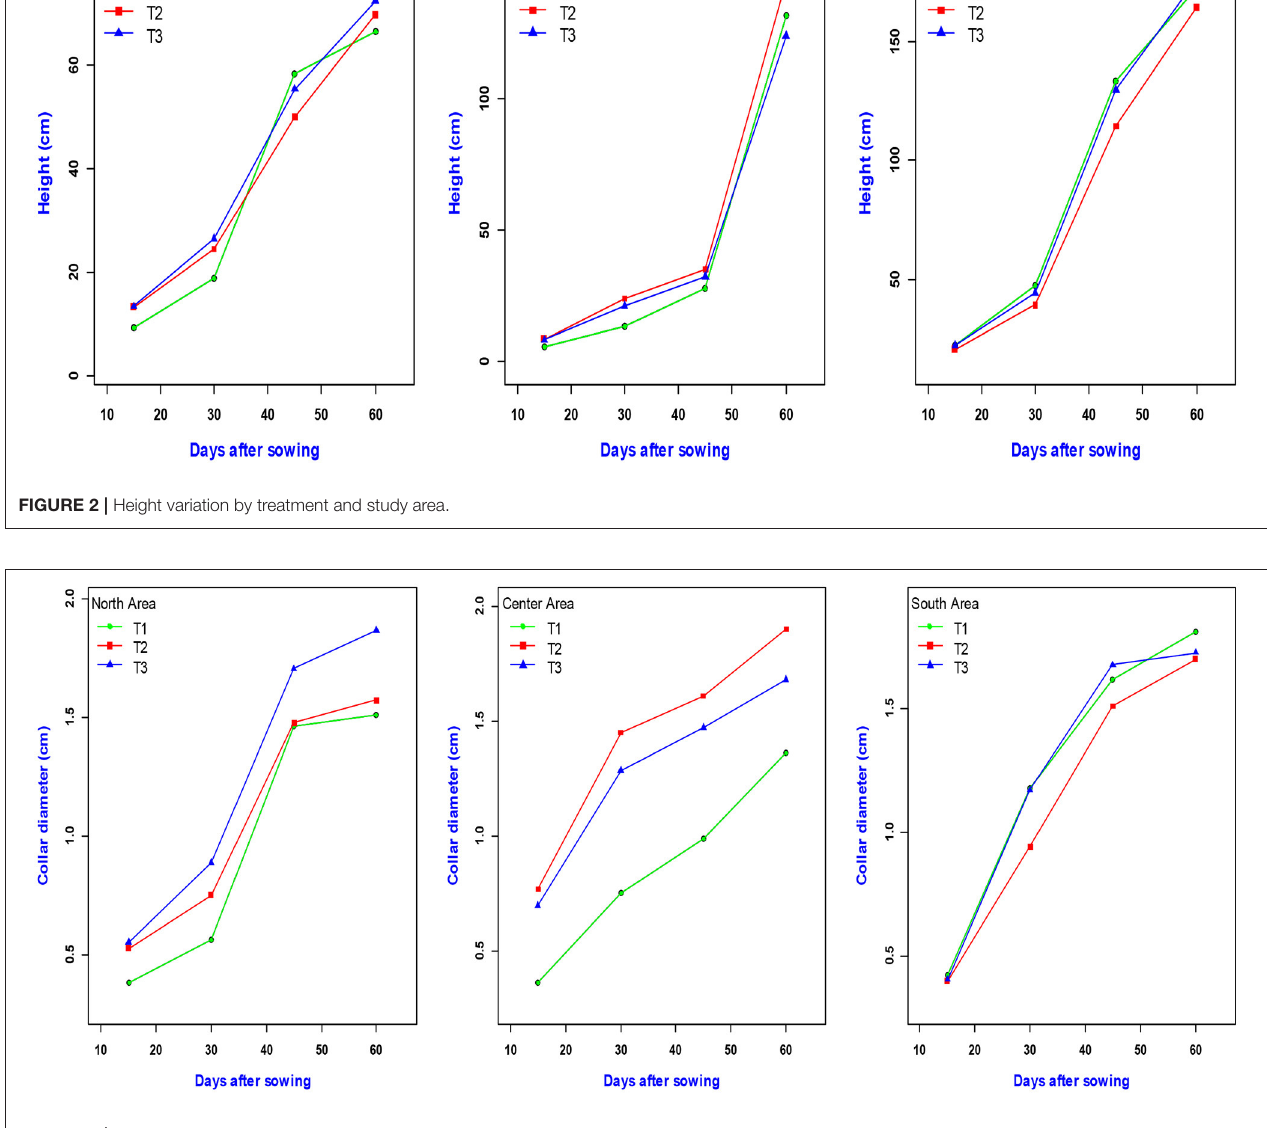
as the adaptation of fungi to different pH levels varies between species. In soils with pH between 7 and 7.6